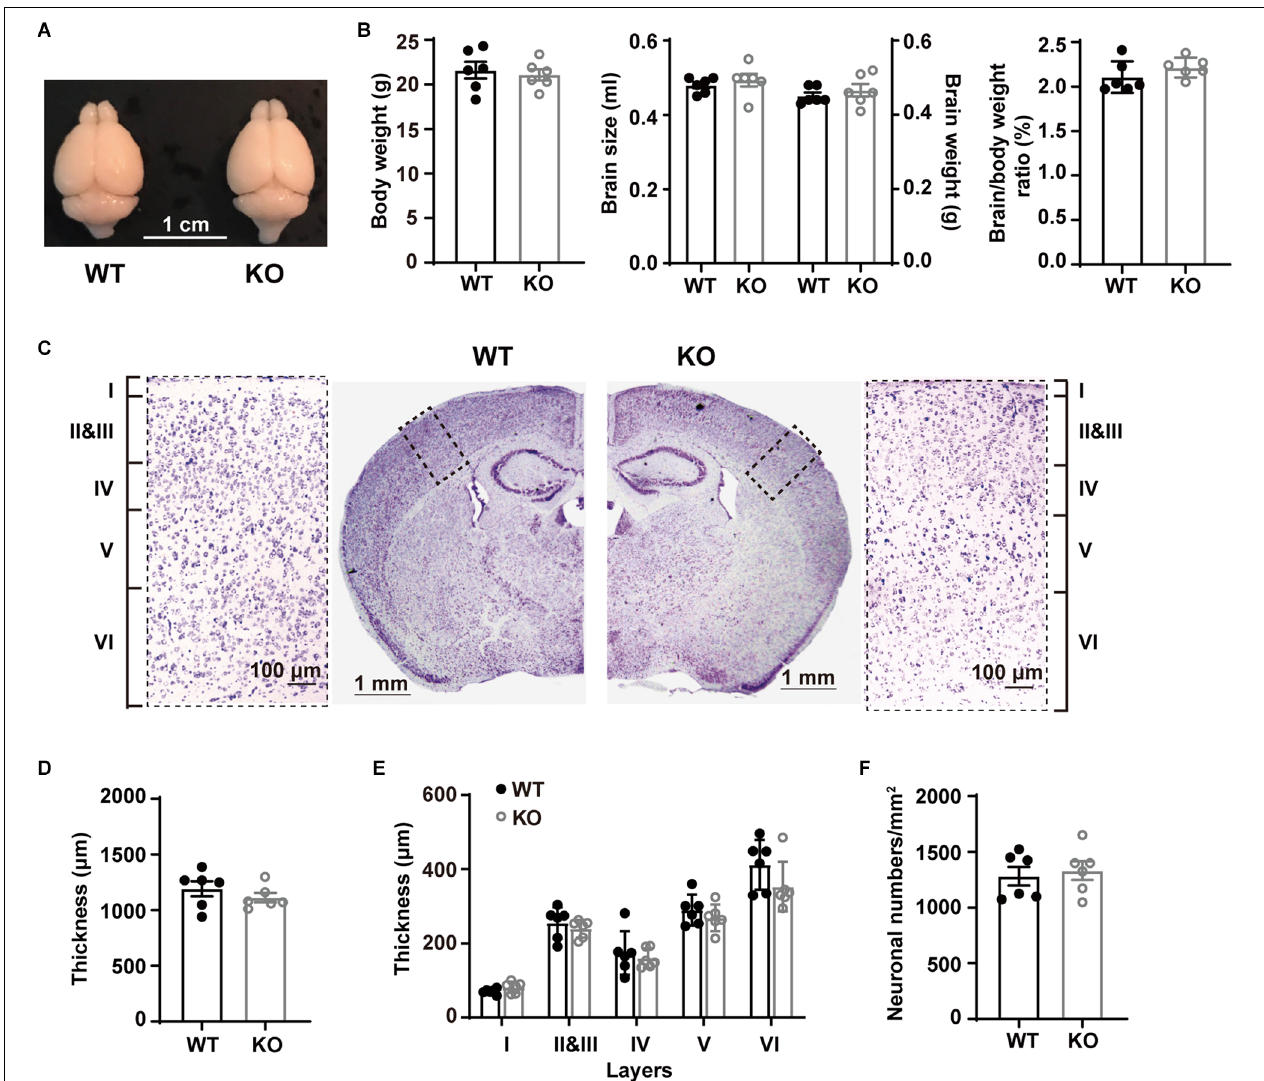
FIGURE 1 | Gross morphological characterization and bodyweights of WT and p53KO mice. (A) Representative photographs of WT and p53KO mice brains. (B) Body weight, brain size, brain weight, and brain/body weight ratio of WT and KO mice. (C) Nissl staining of coronal brain sections and enlargement of boxed areas. Left: WT; right: KO. (D) Quantification of cortical thickness in S1BF. (E) Thickness of cortical layers I, II-III, IV, V, and VI in S1BF. (F) Quantification of neuron density in L5 of S1BF from mice examined in (C)